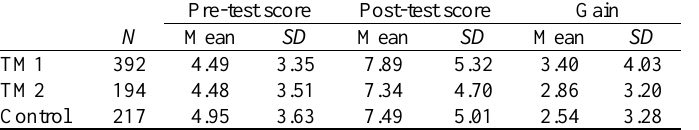
Table 3 Mean pre- and post-test scores, and gains for the TM1 and TM2 classes separately Pre-test